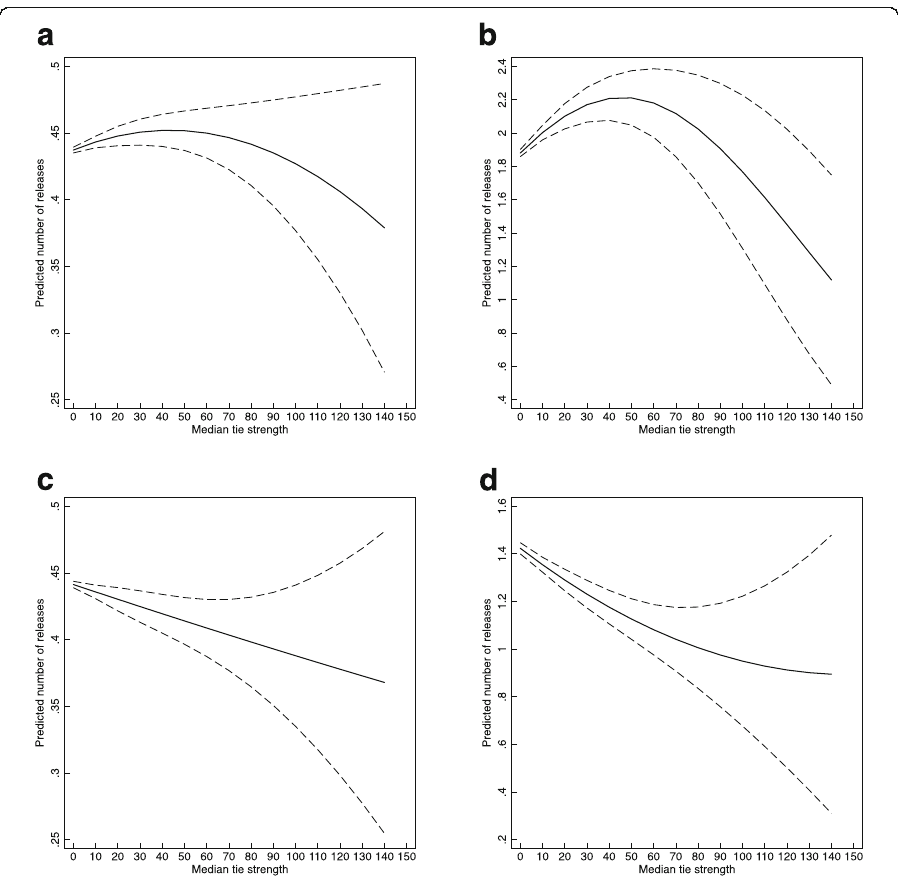
Fig. 8 Marginal prediction of number of releases for median tie strength, with 95% confidence intervals. a OLS model of log(Releases), b NB model of Releases, c OLS model of log(Releases) with fixed effects,